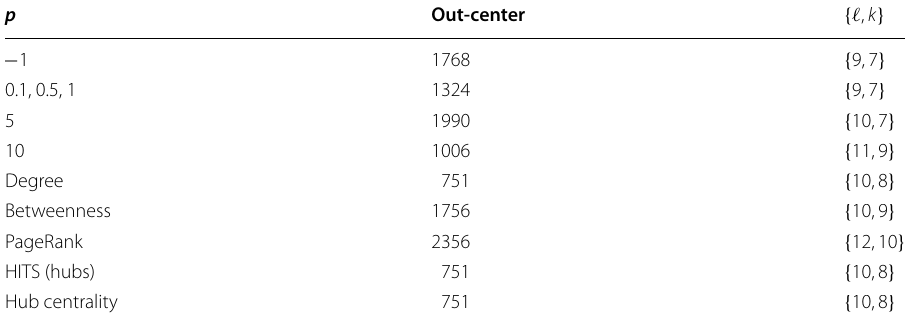
For each vertex we also report the depth ℓ of the associated spanning tree and the minimal lower bandwidth k of the corresponding { ℓ , k } -chained